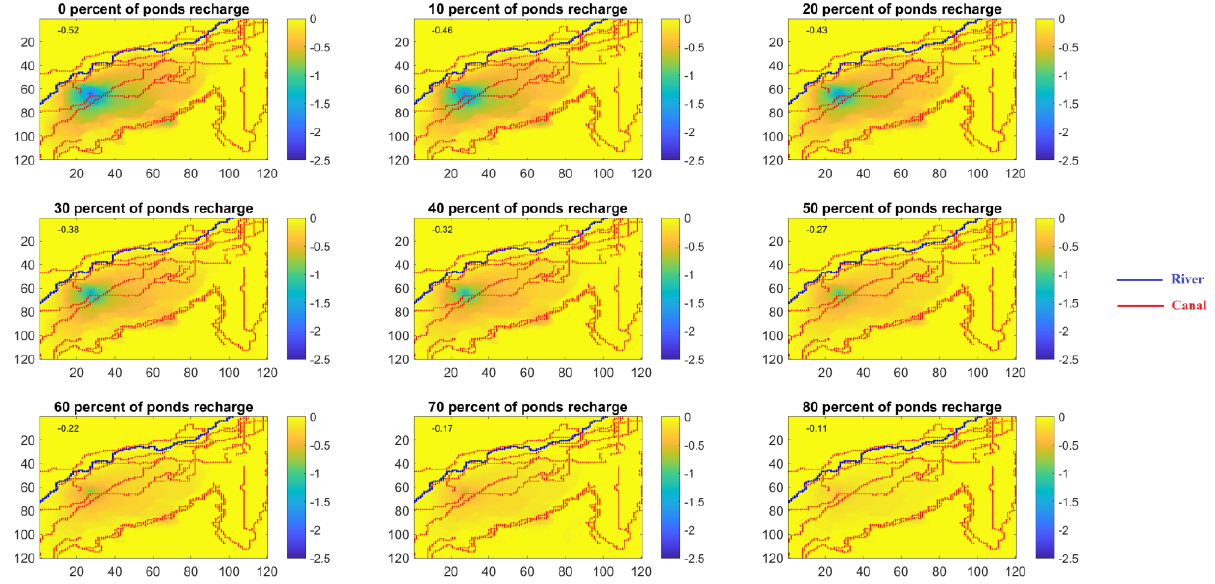
Figure 8. The head drop with applying 0% to 80% with current recharge ponds leak rate across the entire study area. The average decrease in groundwater head (m) is shown in the upper left corner of each subplot.